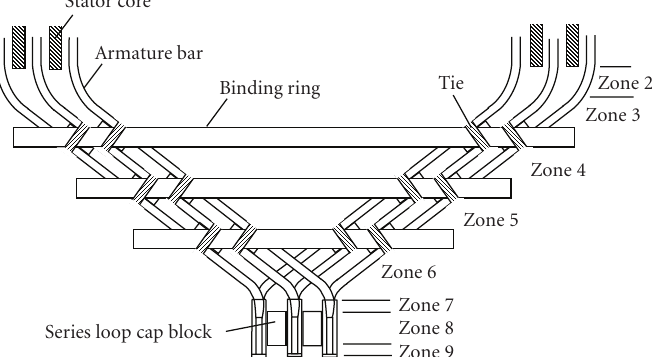
Figure 3: Layout of armature bars, binding bands, and flow zones (only armature bar outer layer presented).